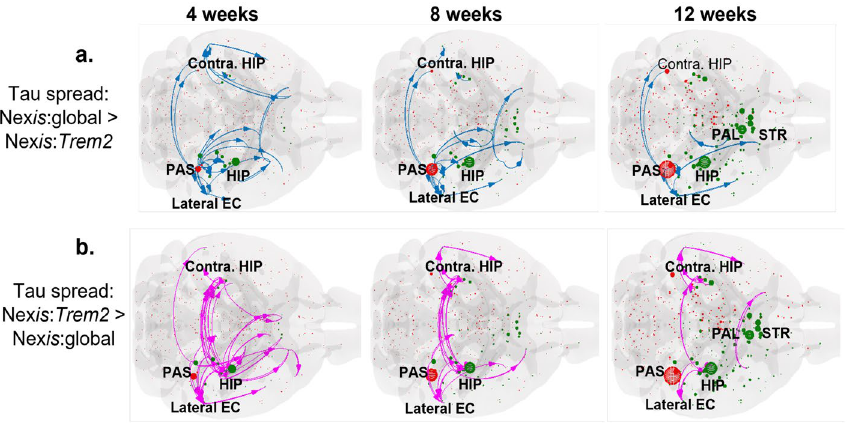
Figure 5. Flow-map representations of tau accumulation and spread in DS9 dataset post hippocampal seeding. Tau burden and spread differences were evaluated between Nex is :global and Nex is : Trem2 modeled tau pathology. Blue arrows of tau spread ( a ) depict Nex is :global-modeled tau flow without the influence of Trem2 and indicate a positive difference (tau spread: Nex is :global > Nex is : Trem2 ). Magenta arrows of tau spread ( b ) depict tau-flow mediated by Trem2 , above and beyond that modeled by Nex is :global and indicate a negative difference (tau spread: Nex is :global < Nex is : Trem2 ). Red and green spheres represent higher tau burden as modeled by Nex is :global and Nex is : Trem2 , respectively. Sphere sizes correspond to the degree of tau burden. HIP: hippocampal area, contra. HIP, contralateral hippocampal area; lateral EC, lateral entorhinal cortex; PAL, pallidal area; PAS, parasubiculum; STR, striatal area.